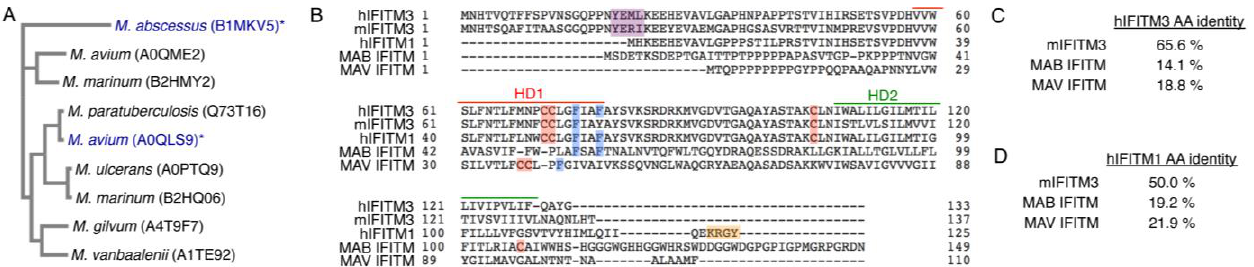
Figure 1. IFITMs from mycobacteria are divergent from vertebrate IFITMs, but possess certain shared amino acid sequence elements. ( A ) A phylogenetic tree of mycobacterial IFITMs generated with Clustal Omega alignments. The mycobacterial species and corresponding UniProt accession number for each IFITM is indicated. IFITMs from MAB ( M. abscessus ) and MAV ( M. avium ) that were chosen for further investigation are denoted with blue text and an asterisk; ( B ) Alignment of human (h) IFITM3, mouse (m) IFITM3, hIFITM1, MAB IFITM, and MAV IFITM. Hydrophobic domain (HD) 1 is highlighted with a red bar and HD2 is highlighted with a green bar. The Yxx Φ motifs of hIFITM3 and mIFITM3 are shaded purple. Known S -palmitoylated cysteines in hIFITM3, mIFITM3, and hIFITM1, and potentially S -palmitoylated cysteines in MAB and MAV IFITMs are shaded red. Phenylalanines known to be involved in dimerization of IFITM3, and homologous phenylalanines in MAB and MAV IFITMs are shaded blue. The di-basic KRGY endocytic motif of hIFITM1 is shaded orange; ( C ) Amino acid percent identities as determined by Clustal alignment are shown comparing mycobacterial IFITMs with hIFITM3 or ( D ) hIFITM1. For ( C ) and ( D ), amino acid percent identities are also shown for mIFITM3 for comparison.